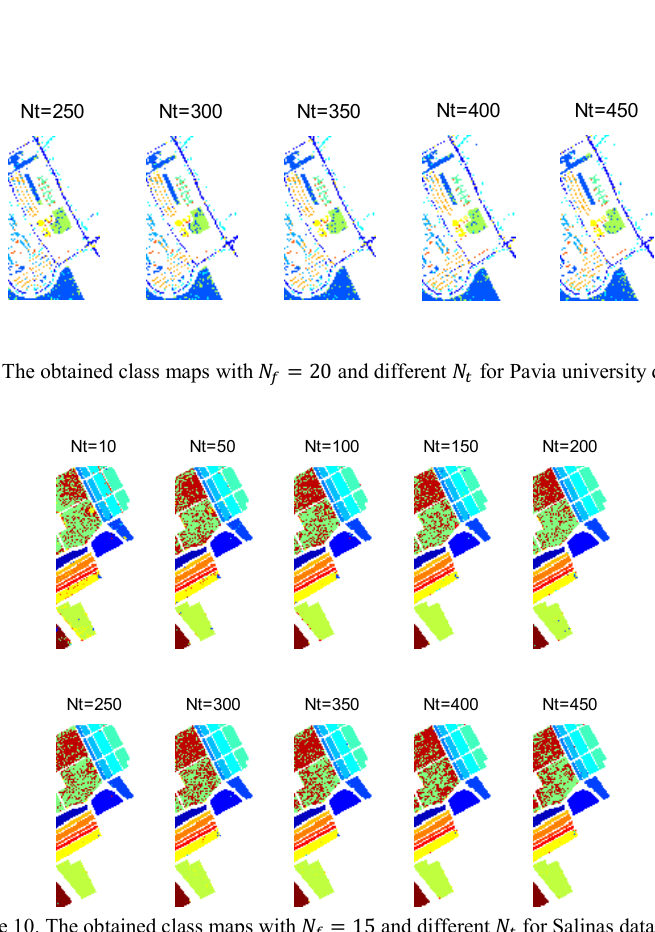
Figure 10. The obtained class maps with (cid:13)